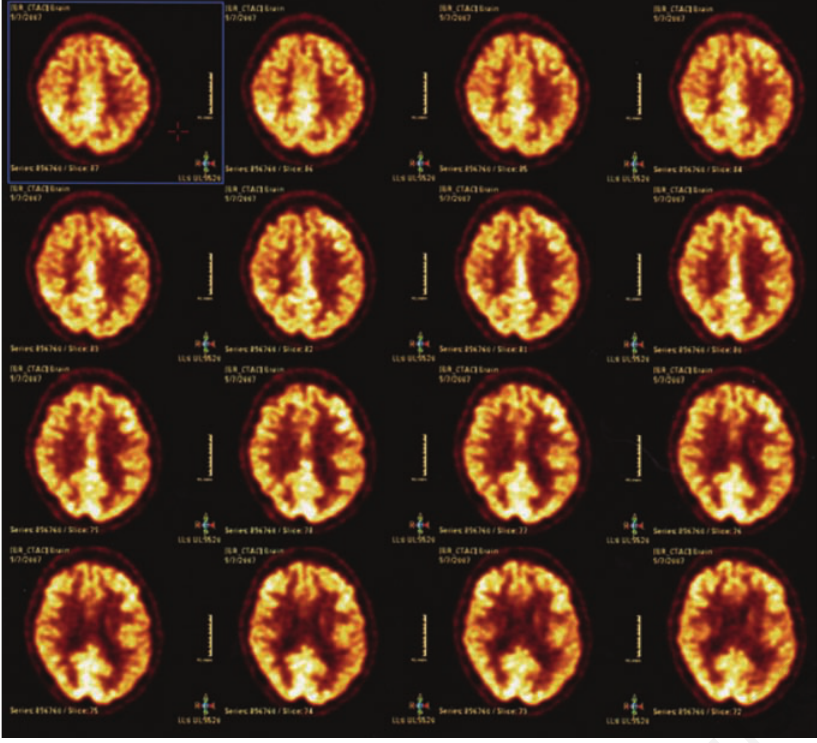
Figure 3. Resolution of symptoms over the next few months with follow-up brain 18F- FDG PET scan showing normal uptake patterns for the cerebral cortex and sub-cortical white matter.